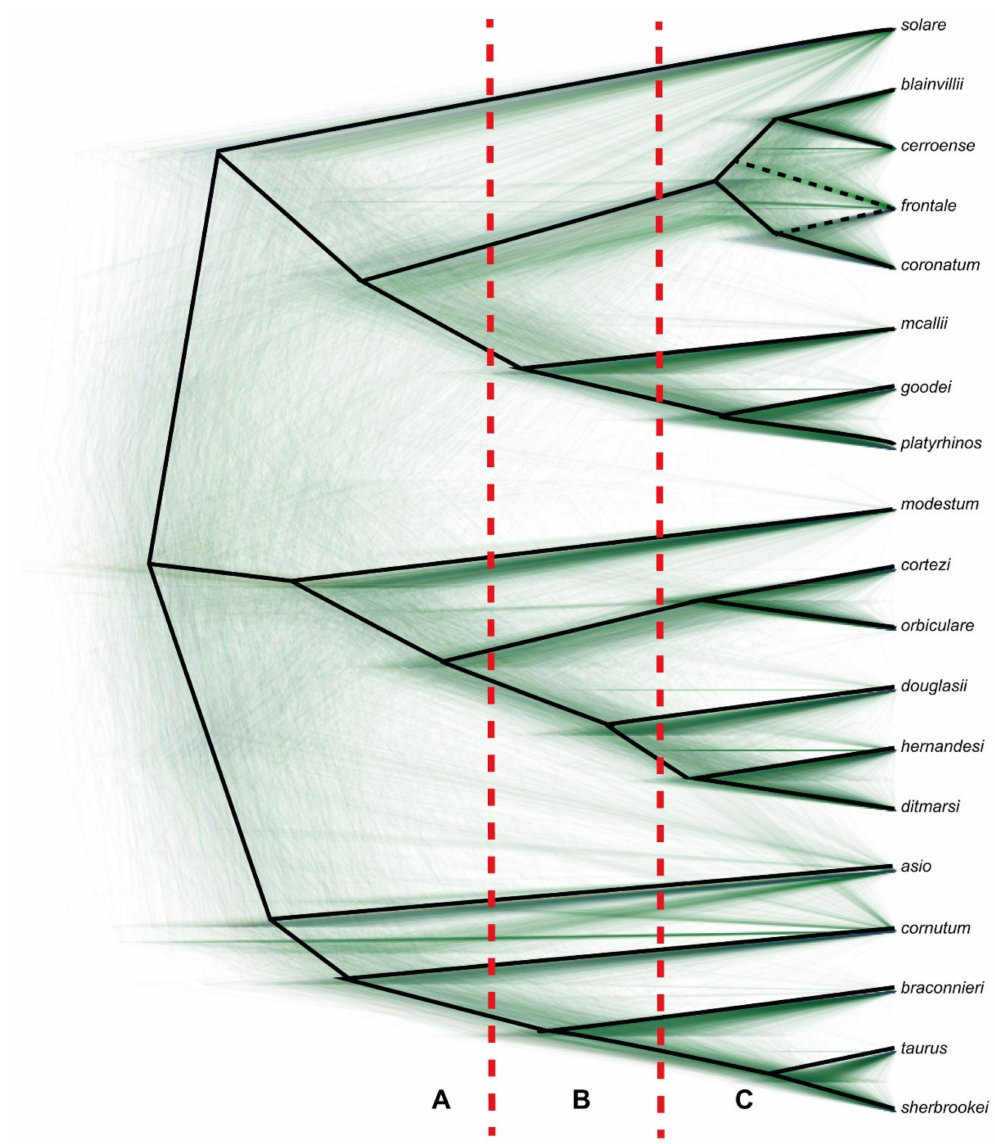
Figure 5. Species tree inferred with BEAST based on the 12S dataset, showing density of trees proportional to frequency of occurrence, drawn in DensiTree. The vertical dashed red lines roughly indicate the percentage difference defining my categories A, B, and C (see text for